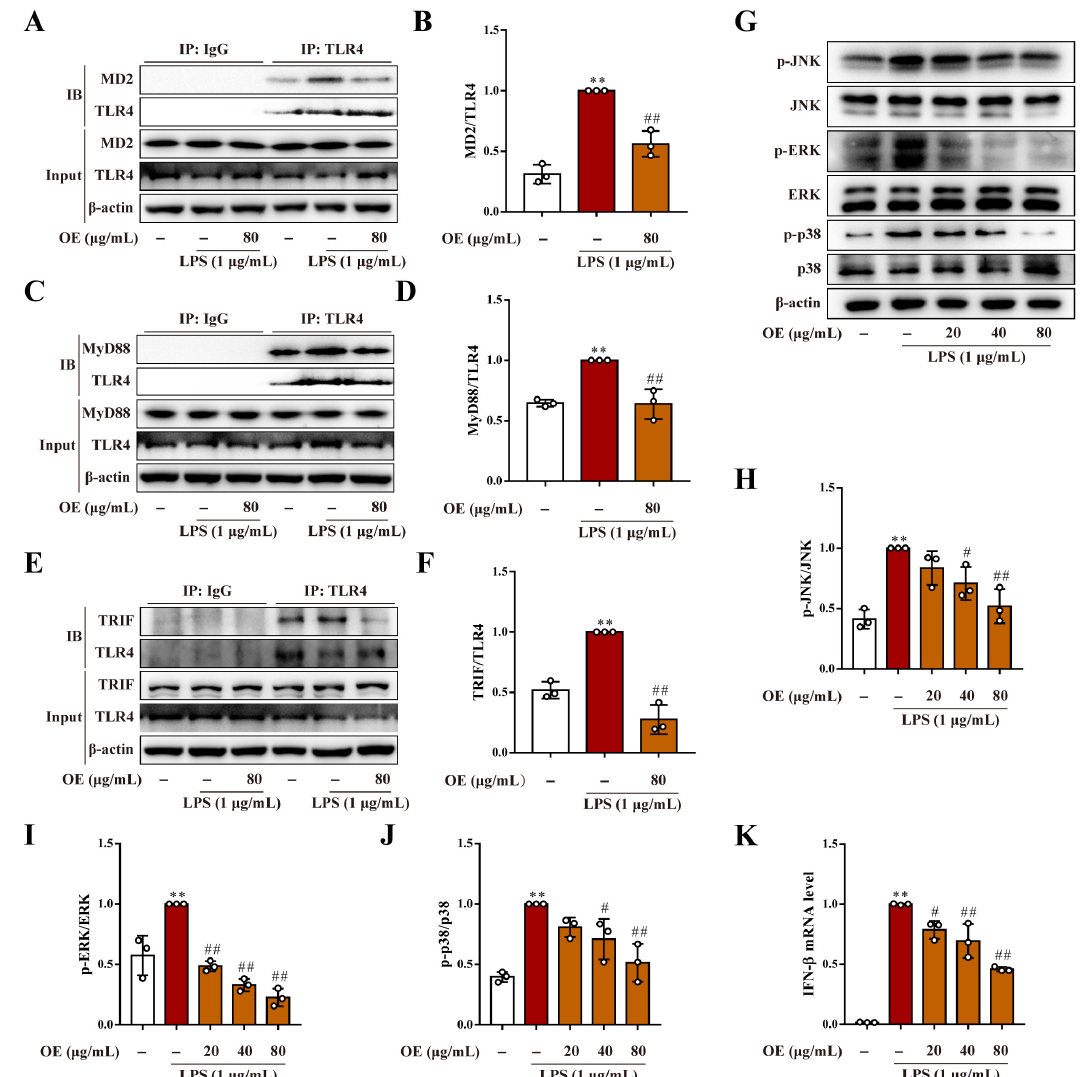
Figure 3. OE inhibited TLR4/MD2 complex formation. ( A – F ) RAW264.7 macrophages were pre- treated with OE (80 μ g/mL) for 3 h followed by stimulation with LPS (1 μ g/mL) for 2 h. Interaction between TLR4/MD2 ( A , B ), TLR4/MyD88 ( C , D ), and TLR4/TRIF ( E , F ) were determined by a co-immunoprecipitation assay. ( G – J ) RAW264.7 macrophages were pretreated with OE (20, 40, 80 µ g/mL) for 3 h followed by stimulation with LPS (1 µ g/mL) for 2 h, and protein expression of p-JNK, JNK, p-ERK, ERK, p-p38, and p38 was determined by a western blotting assay. ( K ) RAW264.7 macrophages were pretreated with OE (20, 40, 80 µ g/mL) for 3 h followed by stimulation with LPS (1 µ g/mL) for 6 h. The IFN- β mRNA level was determined by quantitative real time PCR analysis. Data presented as Means ± SD. ** p < 0.01 vs. control group; # p < 0.05, ## p < 0.01 vs. LPS group; ns, no